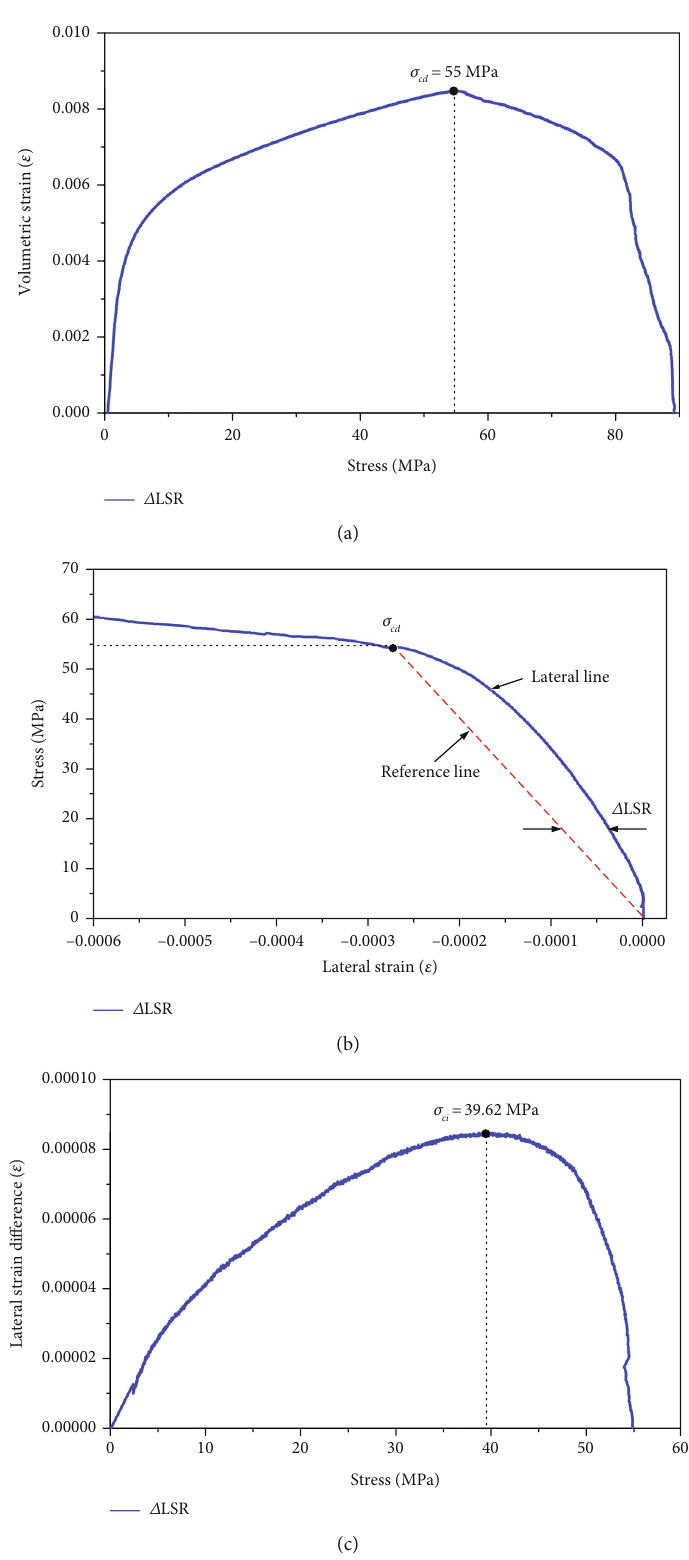
Figure 9: Example of the methodology used to establish the cracking stress ( σ